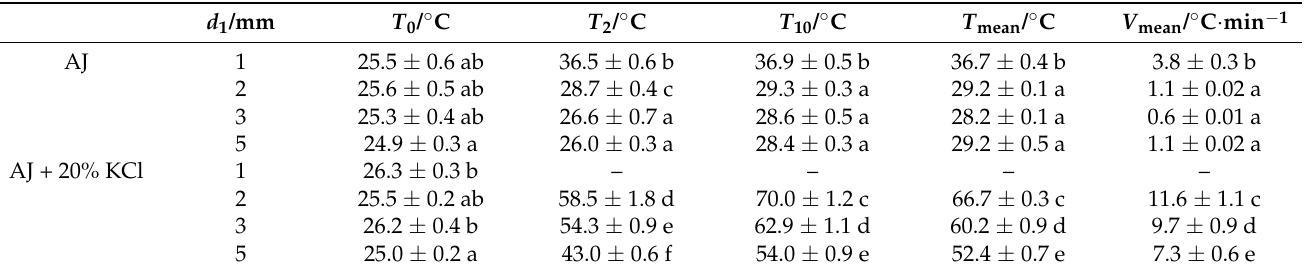
Table 1. Variation of temperature with the change of d 1 level at 800 V, 400 Hz, L 1 = 10 cm, N S = 2 × 19.